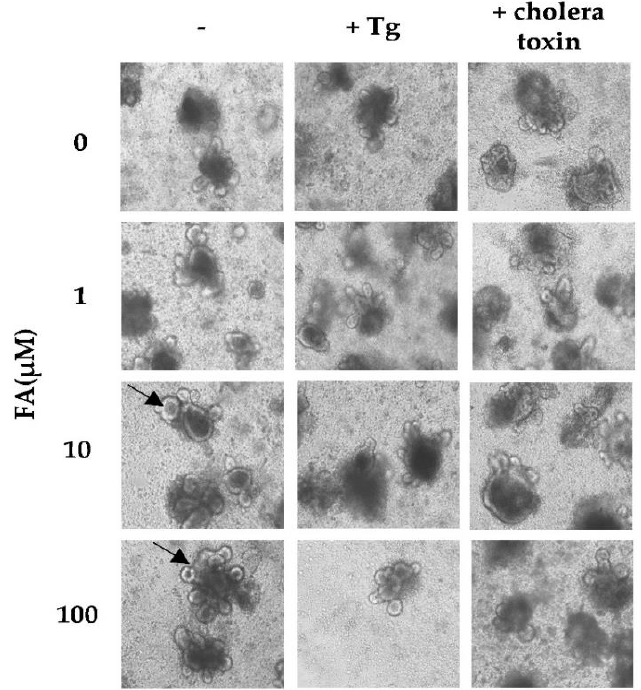
Figure 6. FA enhanced organoid proliferation of mouse small intestines. Small intestines were harvested, and organoids were isolated. Organoids were embedded into 3D Matrigel and cultured in the presence of FA for 1 week with or without 3 uM Tg or 3 nM cholera toxin. Pictures were taken after treatment with 40 × magnification. Arrow shows the new proliferated organoid. Tg: Thapsigargin; FA: Ferulic